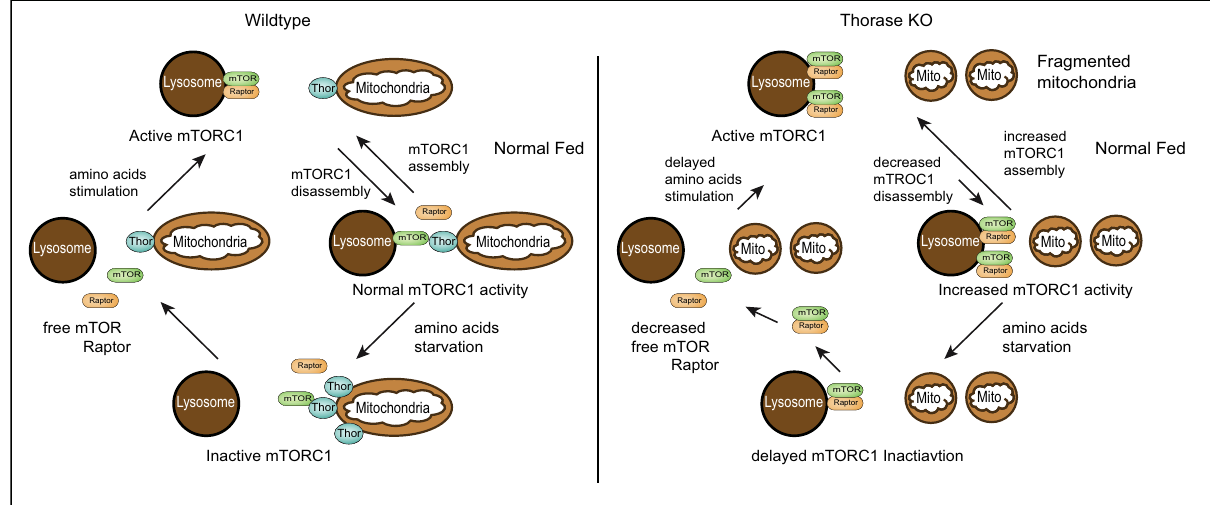
Fig. 8 | A schematic diagram of the proposed mechanism of how Thorase regulates mTORC1 activity. Under normal fed condition in wild type cells, mTORC1 is activated at the lysosome. Our data suggest that mTORC1 is dis- assembled upon lysosome contact with mitochondria where Thorase disassociate mTOR from the mTORC1 complex. During amino acid starvation, increased levels of Thorase at mitochondria results in the disassembly of mTORC1 and disassocia- tion of mTORC1 from lysosome leading to free mTOR and other mTORC1 com- ponents (e.g., Raptor). Upon amino acids stimulation, the freemTOR and mTORC1